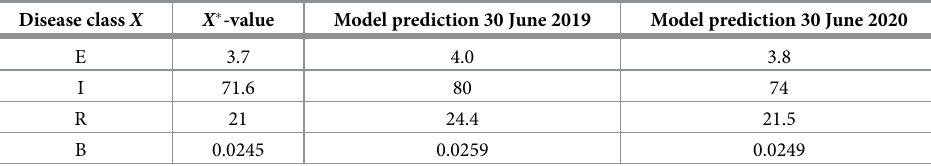
Table 3. Model prediction of listeriosis prevalence in South